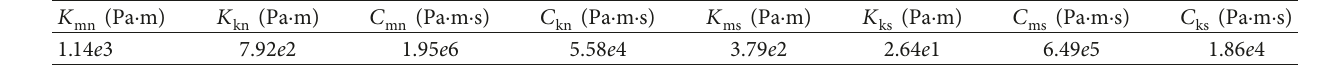
Table 7: Microparameters at contacts within asphalt mastic.